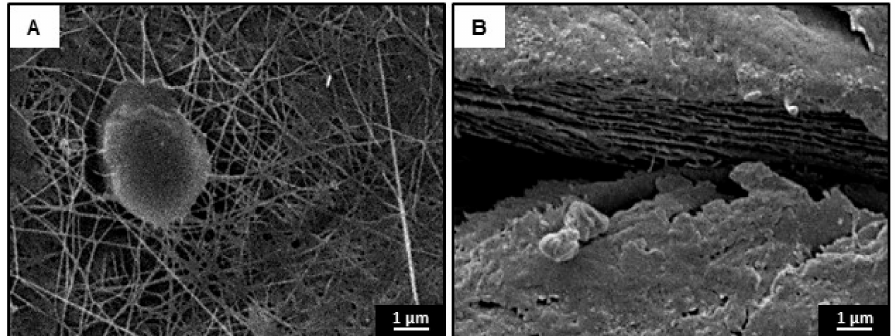
Figure 6. SEM observations of the dried Kombucha cellulose surface at 7000 × magnification ( A ) and cross-sections (7000 × ) ( B ) of cellulose